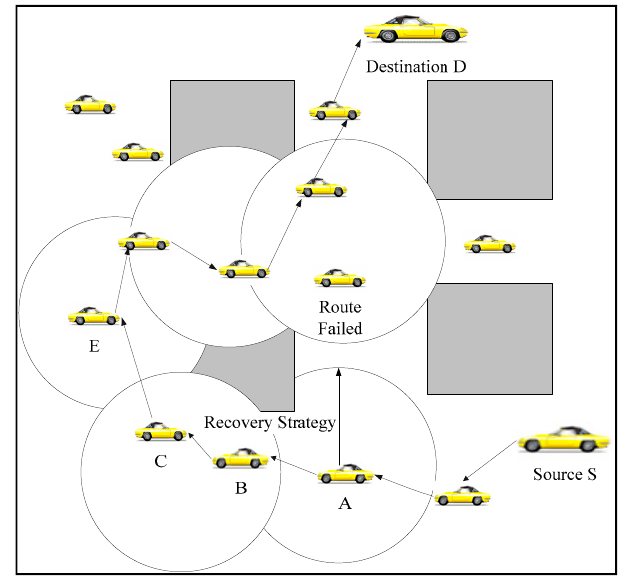
Figure 6. Working of perimeter phase of Greedy Perimeter Stateless Routing (GPSR).